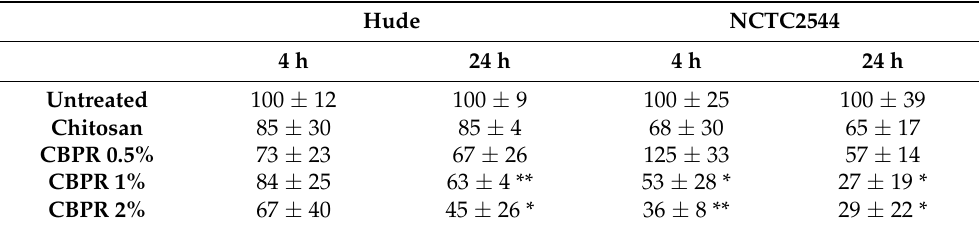
Table 2. Cytotoxicity of CBPR films on human fibroblasts and keratinocytes. Results are expressed as percentage of live cells with respect to untreated cells, assumed to be 100. The results are expressed as mean ± SD of four different